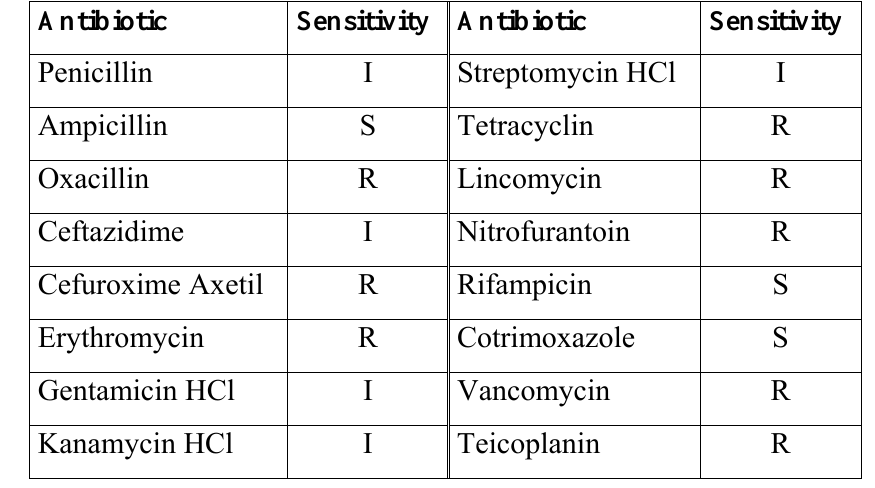
Table 9. Antibiotic sensitivity of the first VRE isolate in Hungary